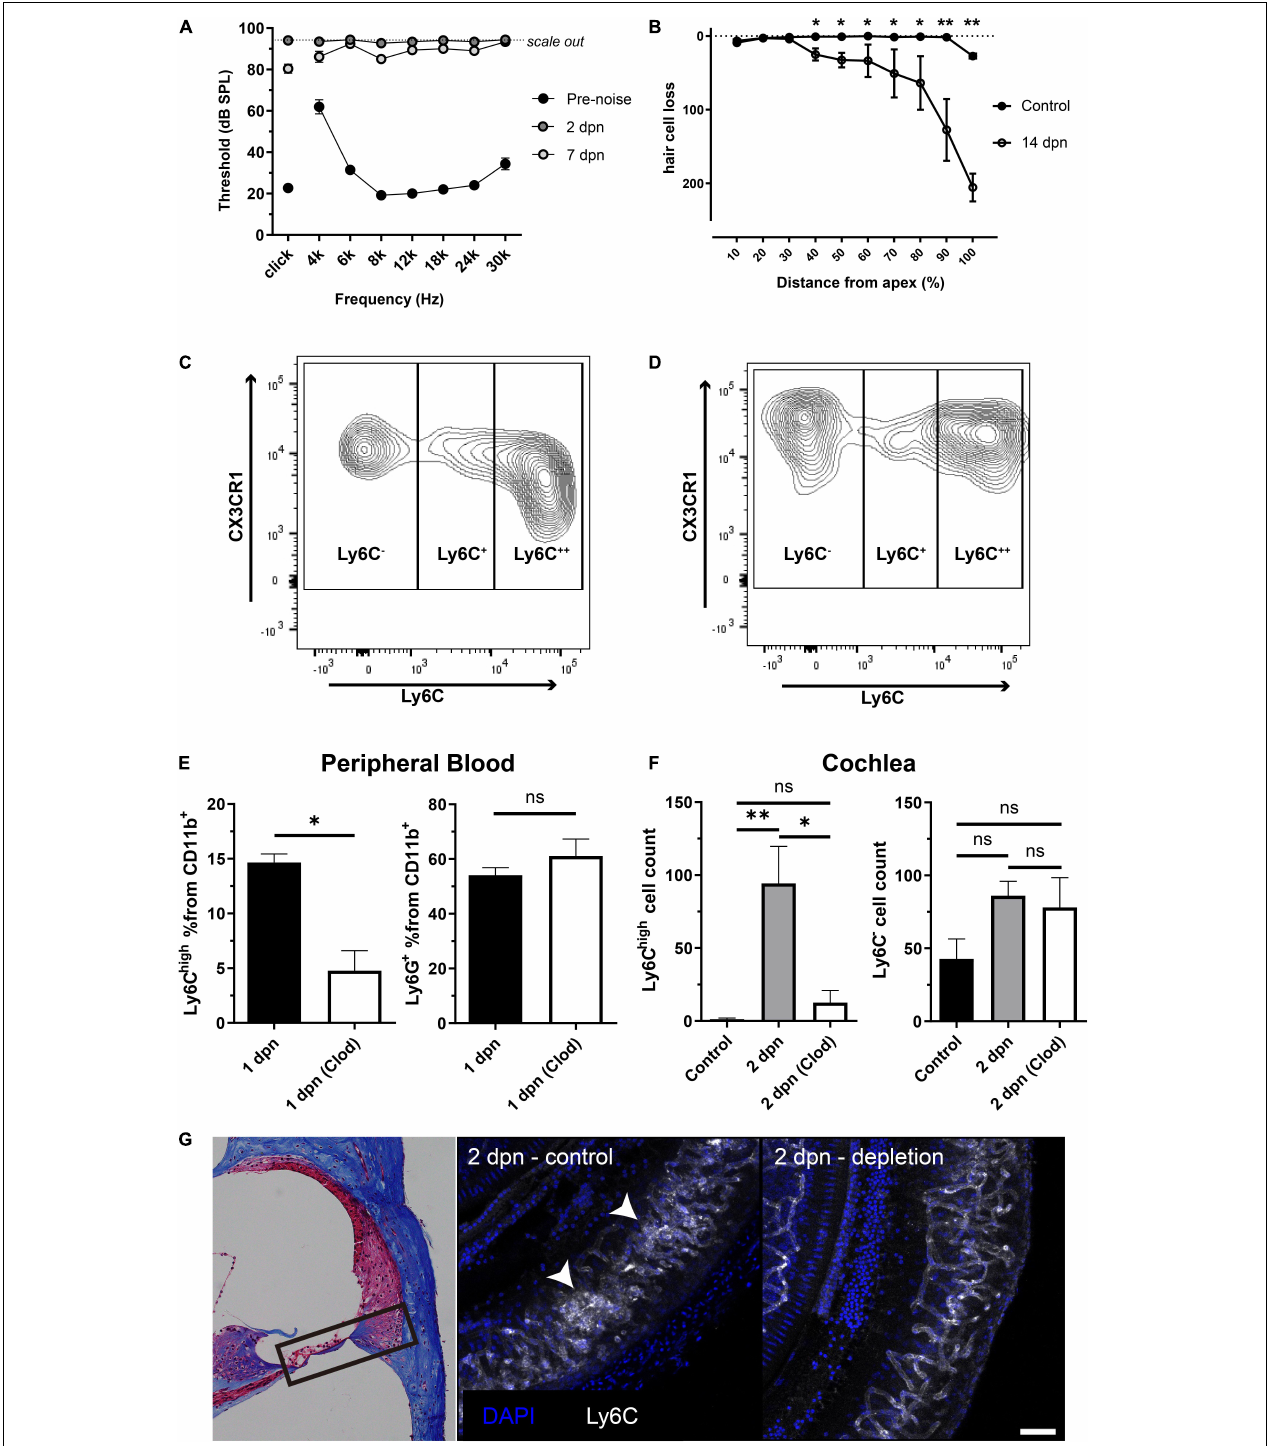
FIGURE 1 | Inflammatory monocytes from the bloodstream infiltrated the cochlea after acoustic overstimulation. (A) Effects of acoustic overstimulation (120 dB, 1 h white band noise exposure) on the permanent threshold shift ( N = 8 ears). (B) Effects of noise exposure on outer hair cell degeneration ( N = 4 ears in each group). (C) Effects of acoustic stimulation on peripheral blood CD11b + Ly6G – F4/80 + CX3CR1 + populations and distinction between Ly6C ++ inflammatory monocytes and Ly6C – patrolling monocytes. (D) Effects of acoustic overstimulation on cell populations (CD11b + Ly6G – F4/80 + CX3CR1 + cells; Ly6C ++ possible inflammatory monocytes and Ly6C – possible resident macrophages) in cochlea at 2 days. (E) Clodronate liposome successfully reduced monocytes in peripheral blood (left)